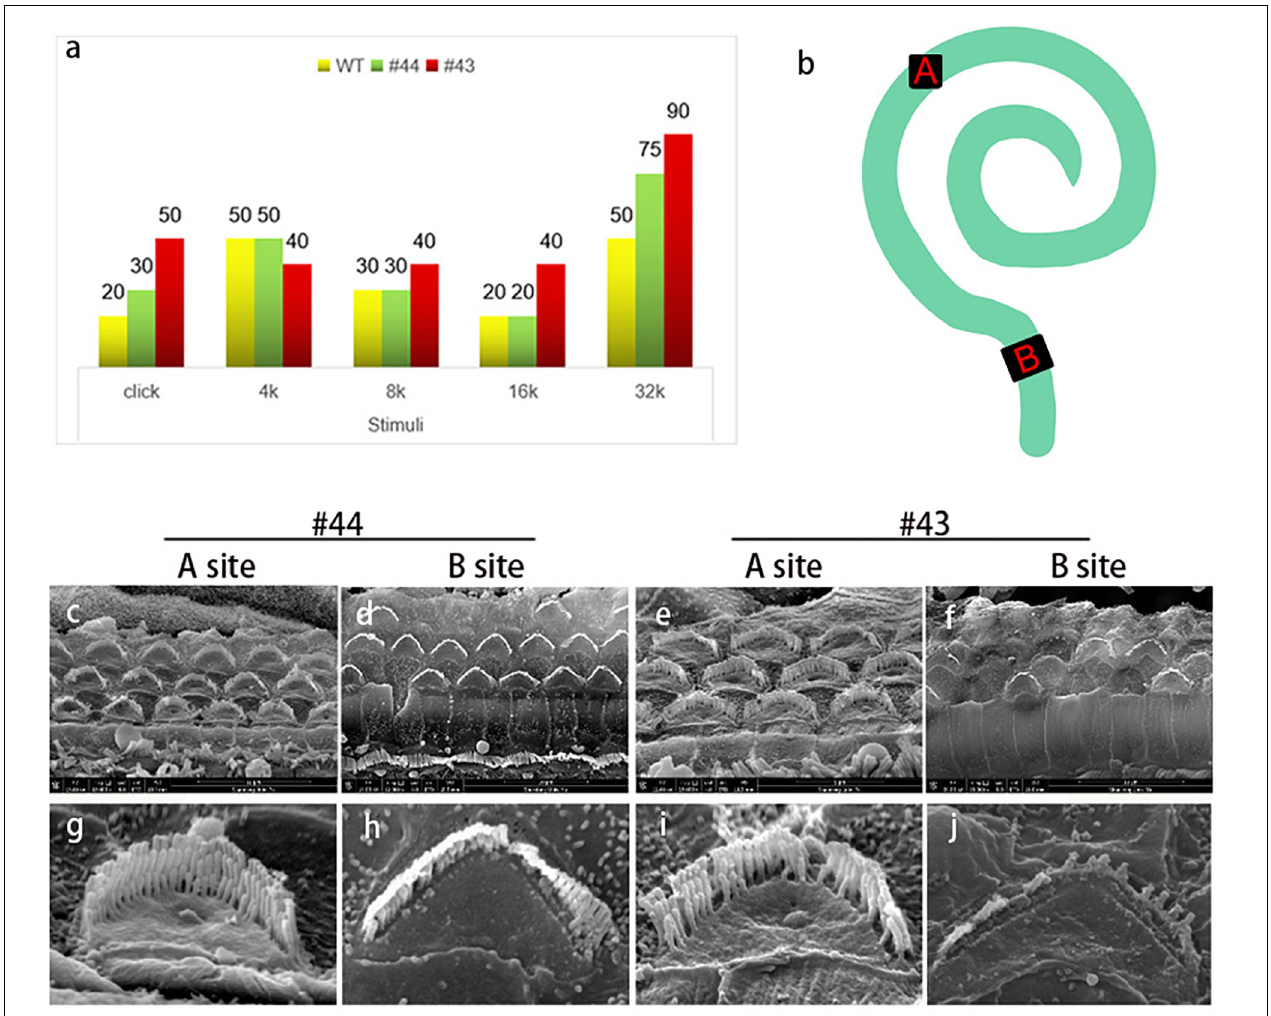
FIGURE 5 | The condition of outer hair cells was closely related to the hearing of the Smpx KO mouse. (a) Auditory brainstem response to a pair of sister mice (#43, #44) with different levels of hearing loss. Two mice were both 1-year-old. (b) Schematic diagram of the whole basilar membrane. Site A represents the middle turn and responses to medium frequency sound waves; site B represents the basal turn and responses to high-frequency sound waves. (c-j) SEM of basilar membranes from the cochlea of #43 and #44 and the amplified image. Comparing (c,g) with panels (e,i) , middle turn hair bundles in panel (g) is normal. The Shortest-row of stereocilia in panel (i) starts to degenerate. Reflected in the ABR, there are 10 and 20 dB threshold shifts in #43 at 8 and 16 kHz (medium-frequency), but it is normal in #44. Comparing (d,h) with panels (f,j) , stereocilia degeneration in #43 is badly worse than that in #44. Large numbers of hair cells’ death in panel (f) resulted in the loss of hearing in a high frequency of #43. The remaining hair cells and stereocilia ensured that #43 maintained a low-level hearing in high